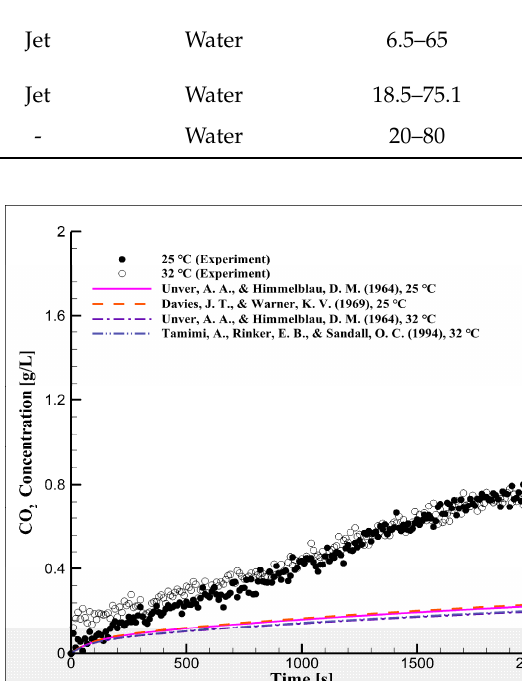
Table 4. CO 2 diffusion coefficients in water as per the literature.